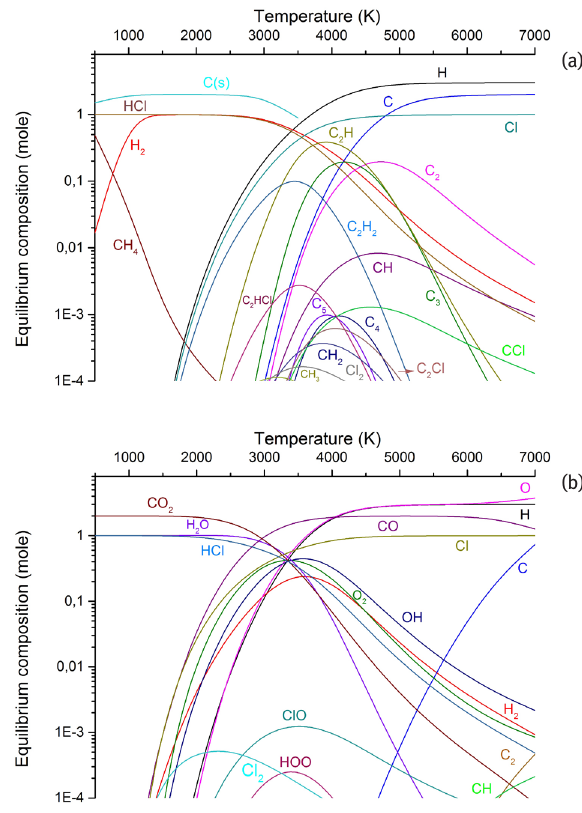
Figure 1 : Thermodynamic calculations for thermal decomposition of PVC in neutral (a) and oxidative (b)